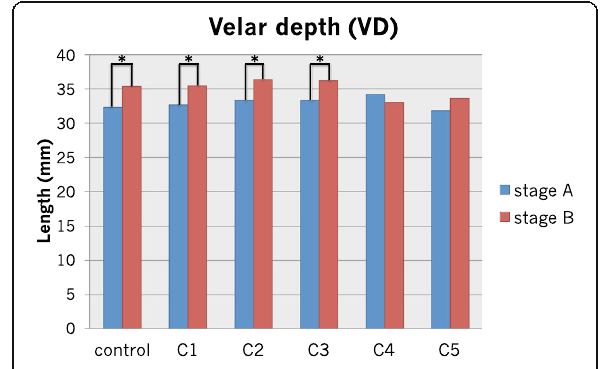
Fig. 5 The length of VD in six conditions at stages A and B